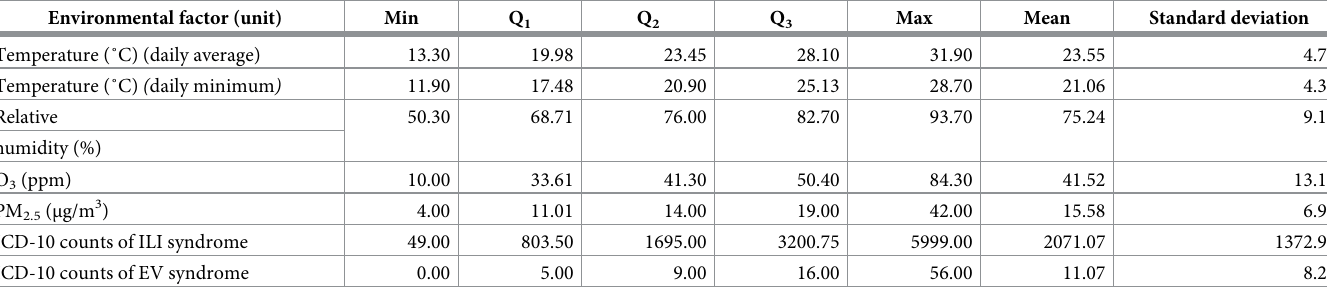
Table 1. Descriptive statistics for daily data of environmental factors and ICD-10 counts of ILI and EV in Taipei City. Environmental factor (unit)